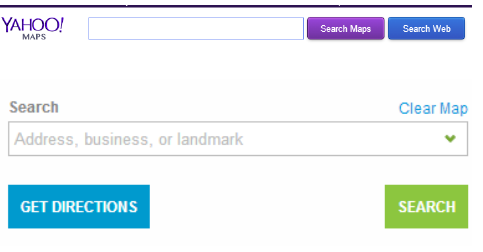
Figure 3 Different Types of Search